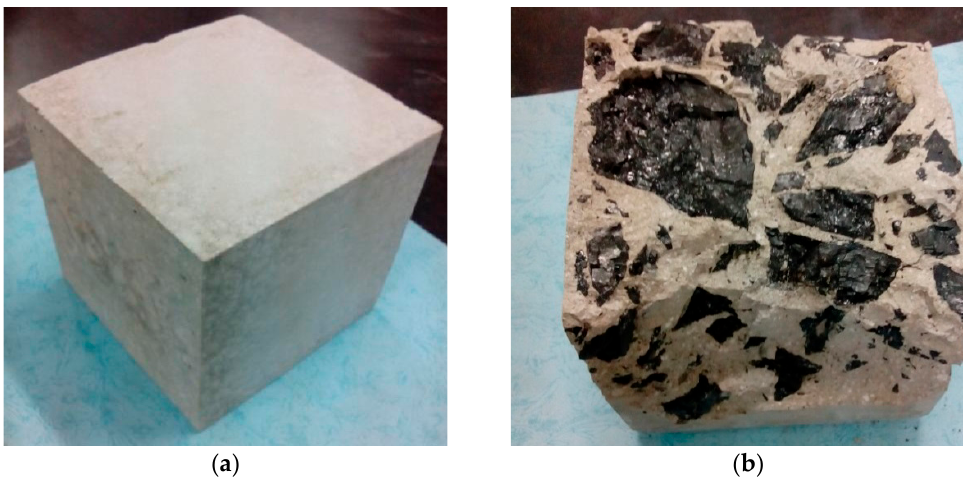
Figure 9. Compression experiment of consolidated coal ( a ) before compression and ( b ) after compression.